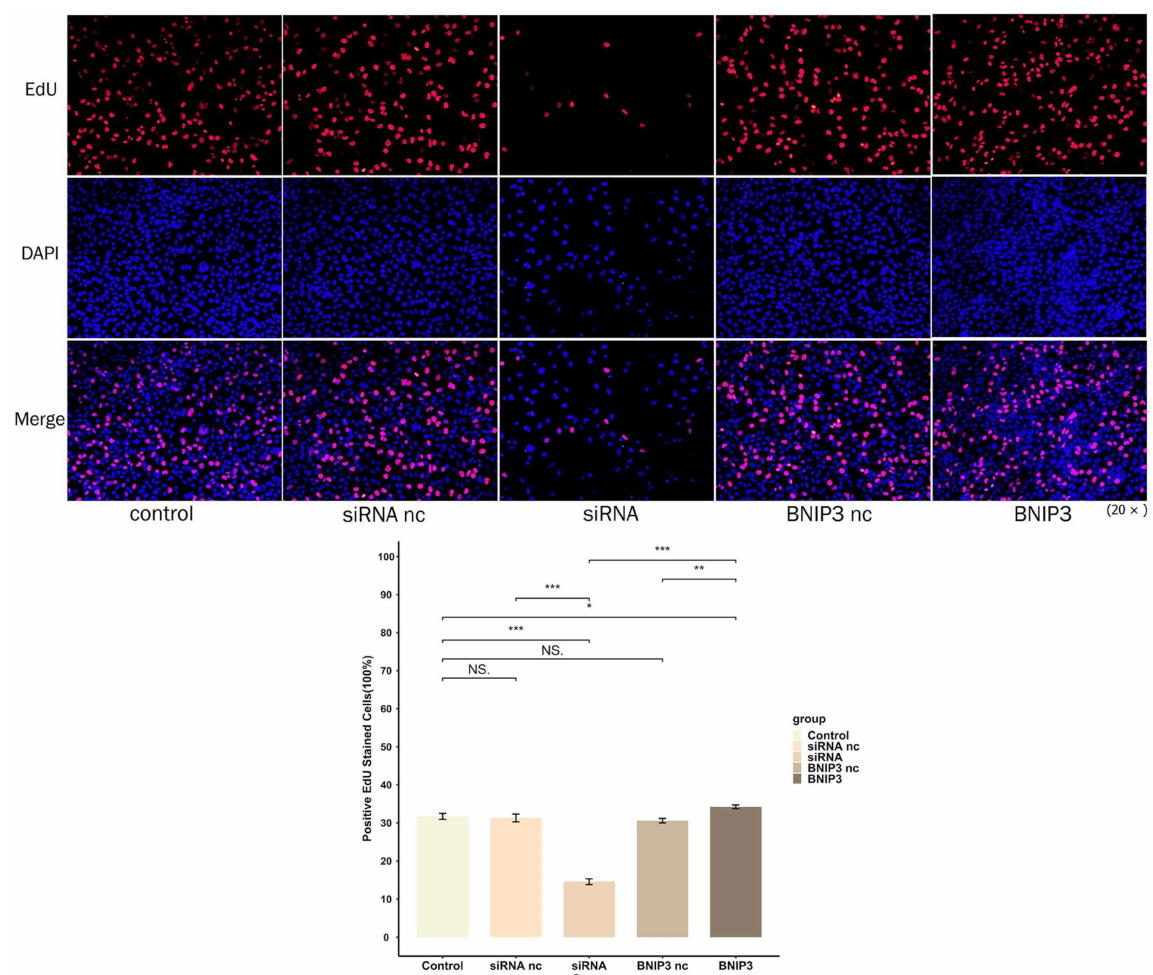
Figure 17. BNIP3 regulates the proliferation of osteosarcoma cells. Knockdown of BNIP3 inhibits the proliferation of osteosarcoma cells, while overexpression of BNIP3 promotes the proliferation of osteosarcoma cells. “NS” represented “No significant difference”, “*” represented “ p < 0.05”, “**” represented “ p < 0.01”, “***” represented “ p < 0.001”.